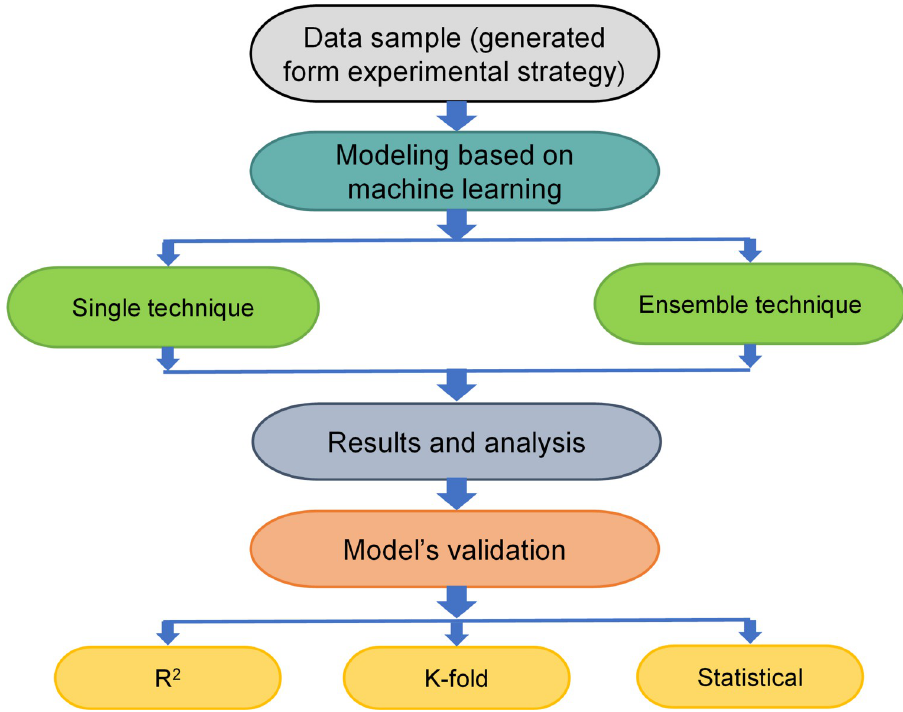
Fig 2. Sequence of ML and validation strategies adopted.